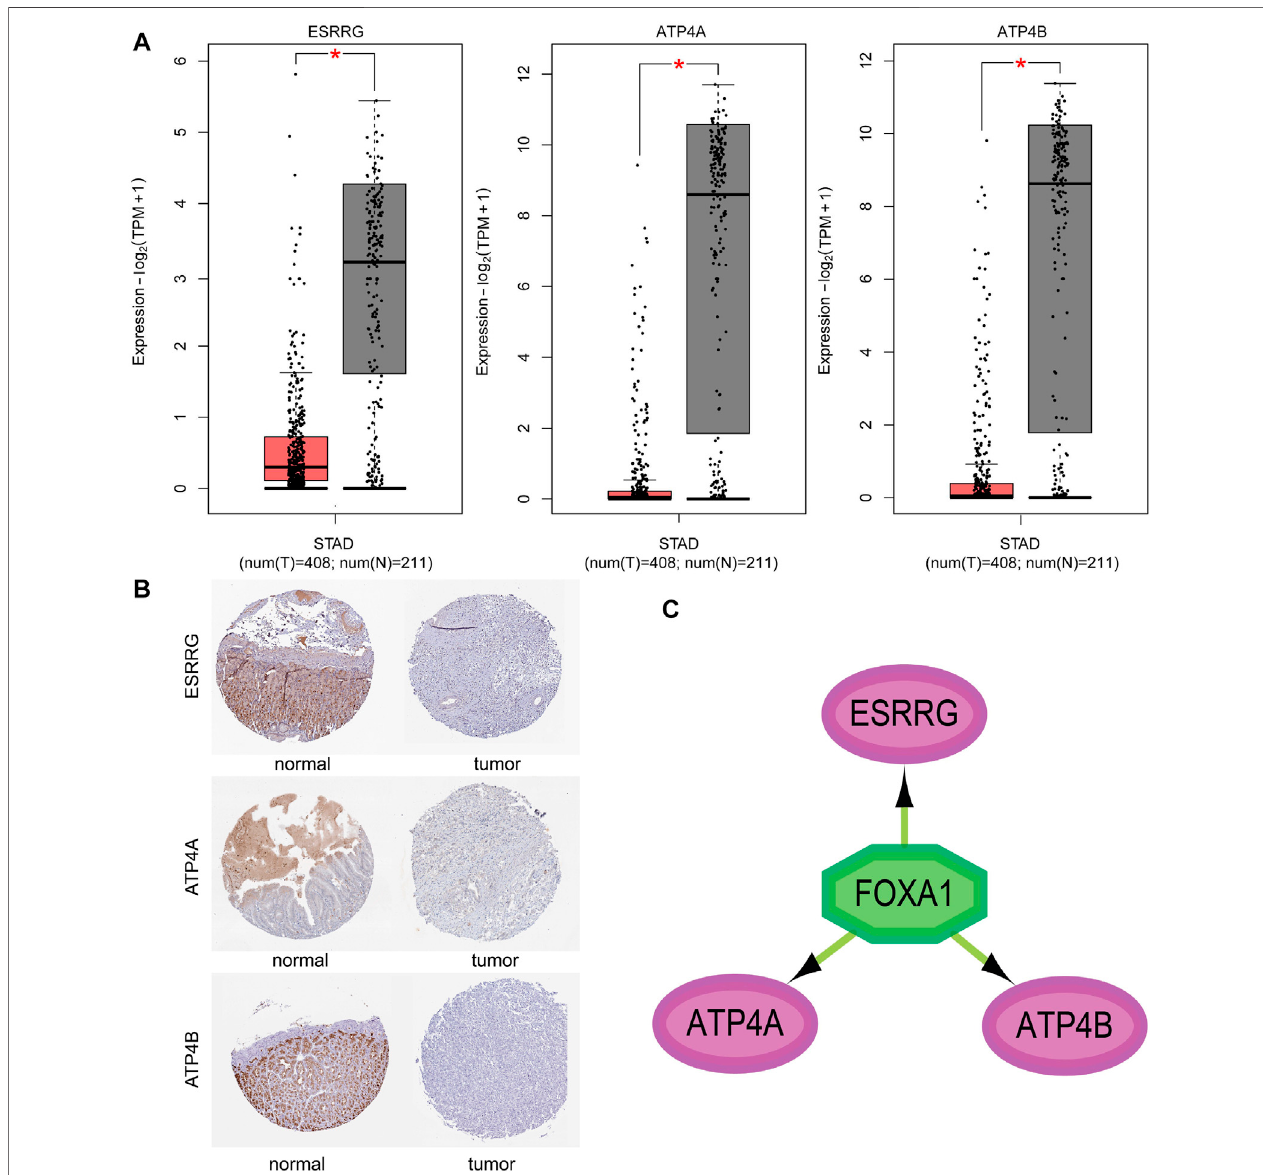
FIGURE5| ValidationofthreehubgeneexpressionsintheGEPIA2platform. (A) ValidationofthreehubgeneexpressionsintheGEPIA2platform.Theredandgray boxes represent cancer and normal tissues in the TCGA and GTEx datasets, respectively. STAD, gastic cancer, and p < 0.01 (GEPIA2 website). (B) Immunohistochemical staining of ESRRG, ATP4A, and ATP4B in the Human Protein Atlas (HPA) database. (C) Transcription factor – hub gene regulatory network of the most relevant factor in the Cytoscape plugin “ iRegulon ” .